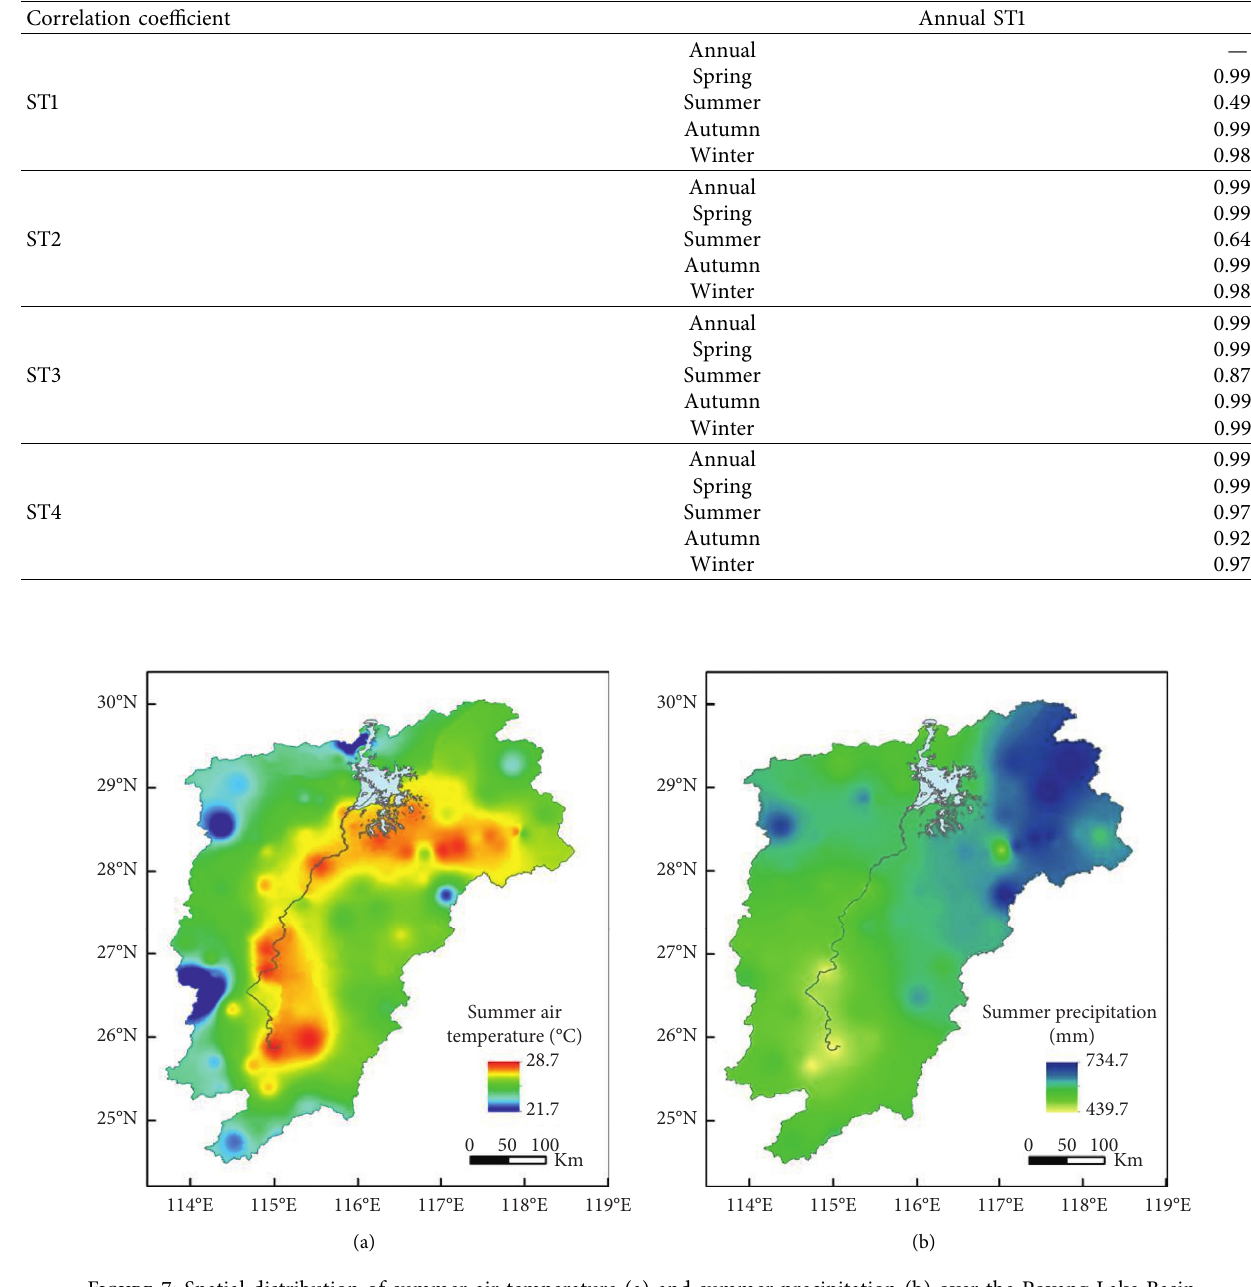
Figure 7: Spatial distribution of summer air temperature (a) and summer precipitation (b) over the Poyang Lake Basin.